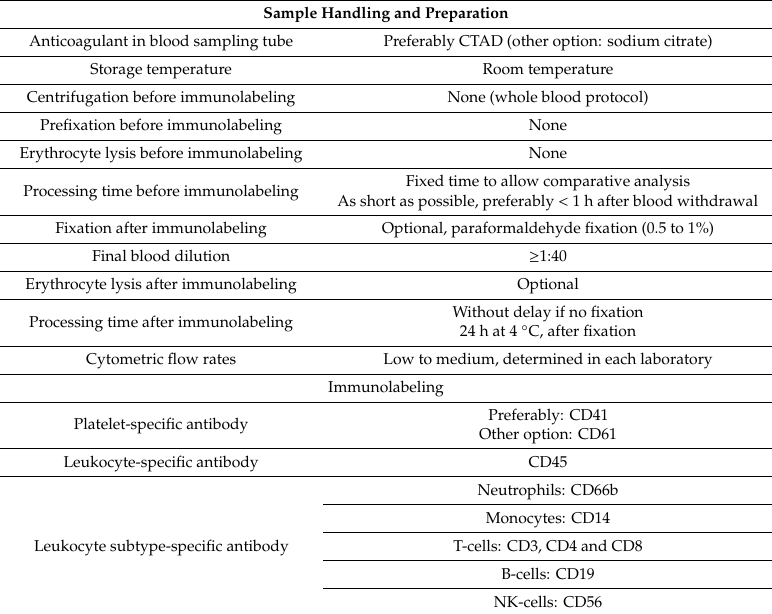
Table 2. Sample preparation and flow cytometric whole blood measurement of circulating platelet–leukocyte aggregates (PLAs). Sample Handling and